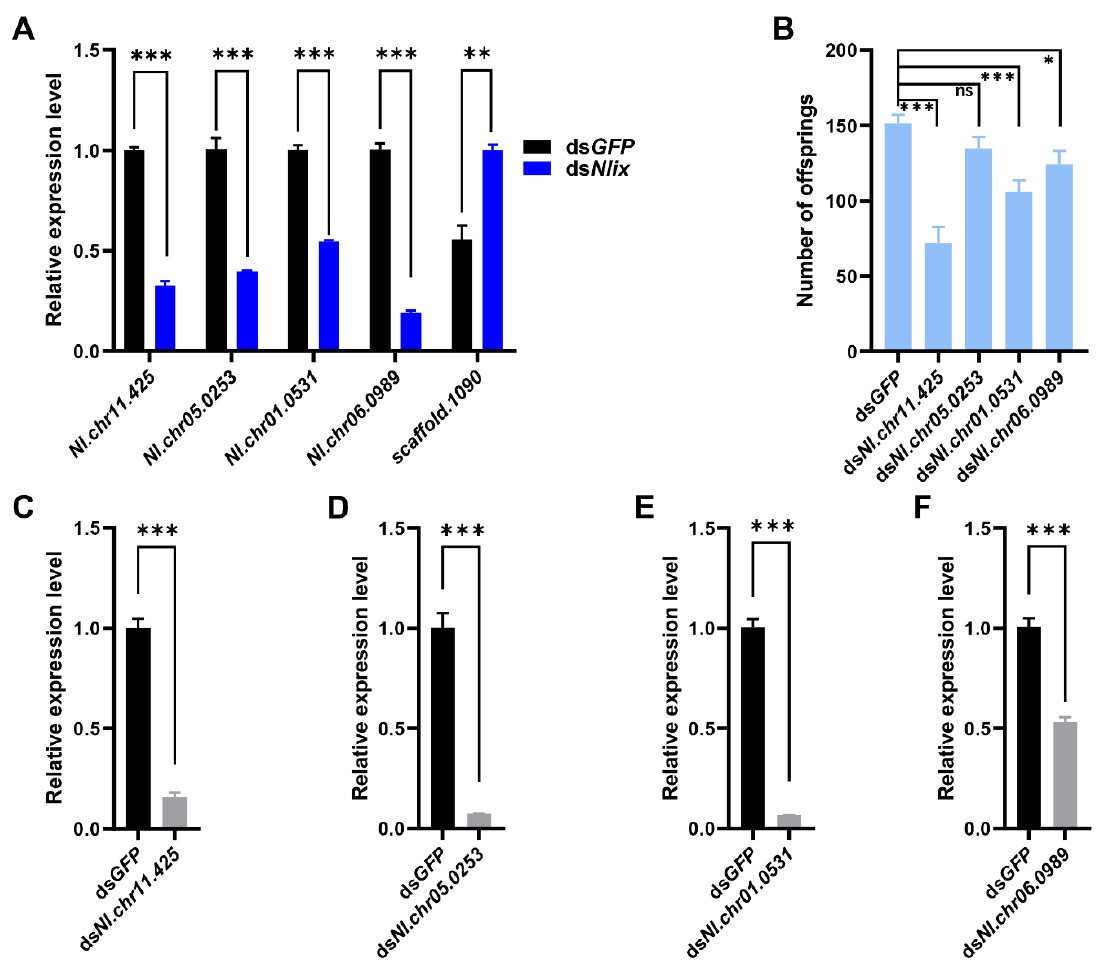
Figure 4. ( A ) qPCR verification of the 5 genes associated with the response to bacteria; ( B ) Number of the offspring produced from the treated females after knockdown of the 4 down-regulated genes associated with the response to bacteria, respectively. Each treatment was carried out in 10 biological replications; ( C – F ) Transcript levels of 4 down-regulated genes after RNAi treatment in the newly emerged females. At 72 h after injection, 10 insects were collected randomly to evaluate the RNAi efficiency. Means ± SEM from three experiments. * p < 0.05, ** p < 0.01, *** p < 0.001 (Student’s t -test); ns: no significant difference.